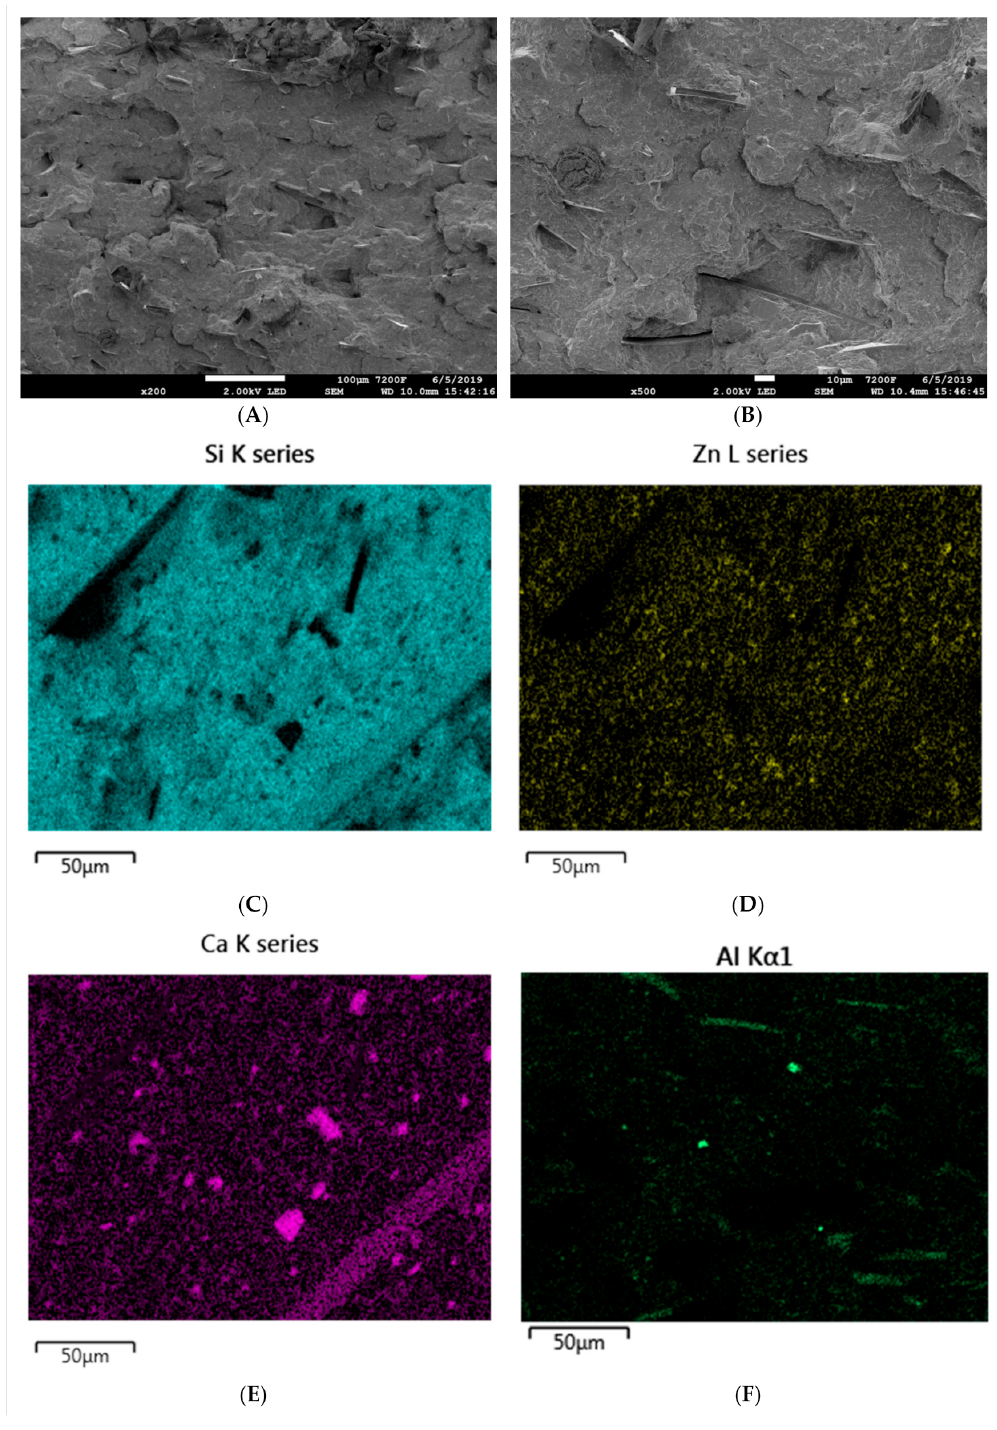
Figure 15. SEM images of the SR-6 composite at magnifications of ( A ) × 200 and ( B ) × 500. EDS mapping of SR-5 ( C ) silicon distribution, ( D ) zinc distribution, ( E ) calcium distribution, and ( F ) aluminum